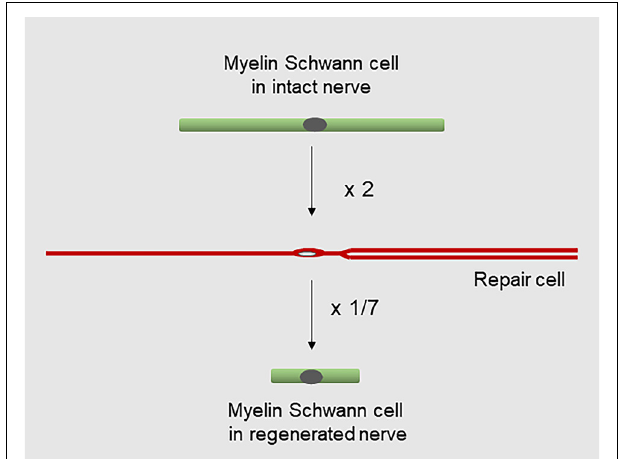
FIGURE 9 | Changes in Schwann cell length during injury and regeneration. Myelin cells elongate about two-fold to generate repair cells, while repair cells shorten about seven-fold to generate new myelin cells after regeneration (for references see